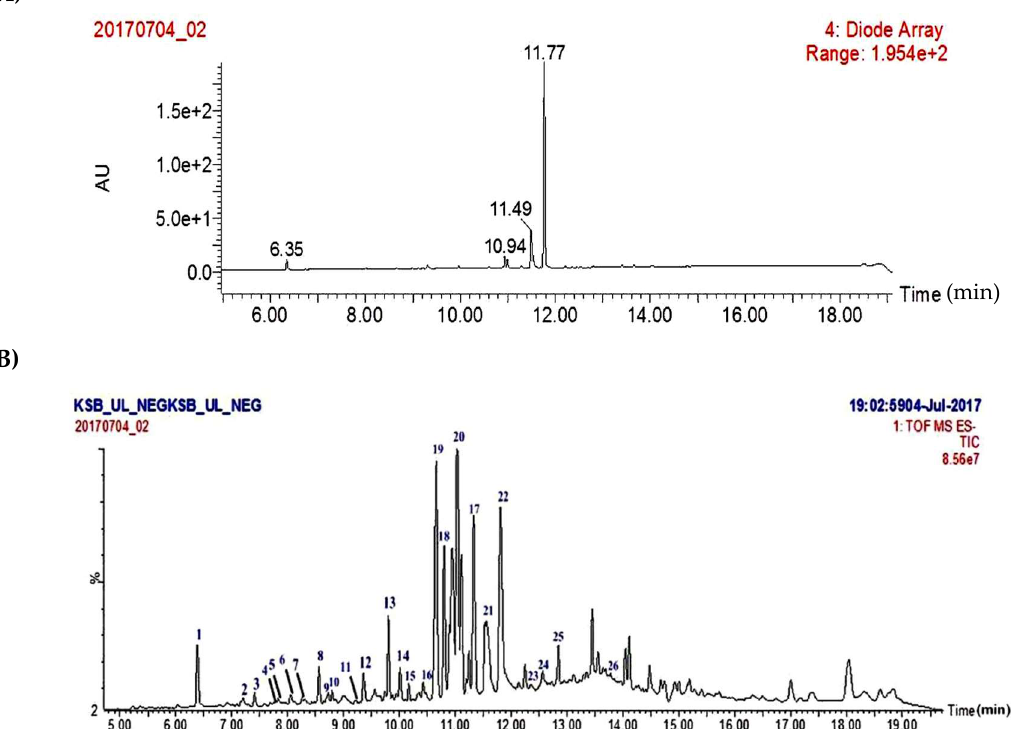
/ MS) of Usnea longissima acetone